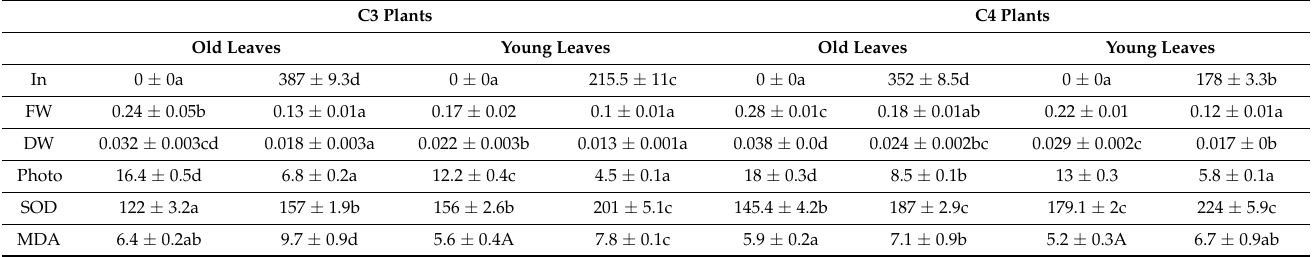
Table 2. Effect of indium oxide nanoparticles and/or elevated CO 2 (eCO 2 ) on indium (In) accu- mulation, fresh and dry weight, photosynthesis rate, lipid peroxidation (MDA) and the activity of superoxide dismutase (SOD) in old and young leaves of C3 and C4 plants. Four biological replicates are used to demonstrate each value ± SE. Fisher’s LSD test ( p < 0.05; n = 4) was used to compare the data for each response separately. Different letters indicate significant differences between means in young and old leaves of C3 or C4